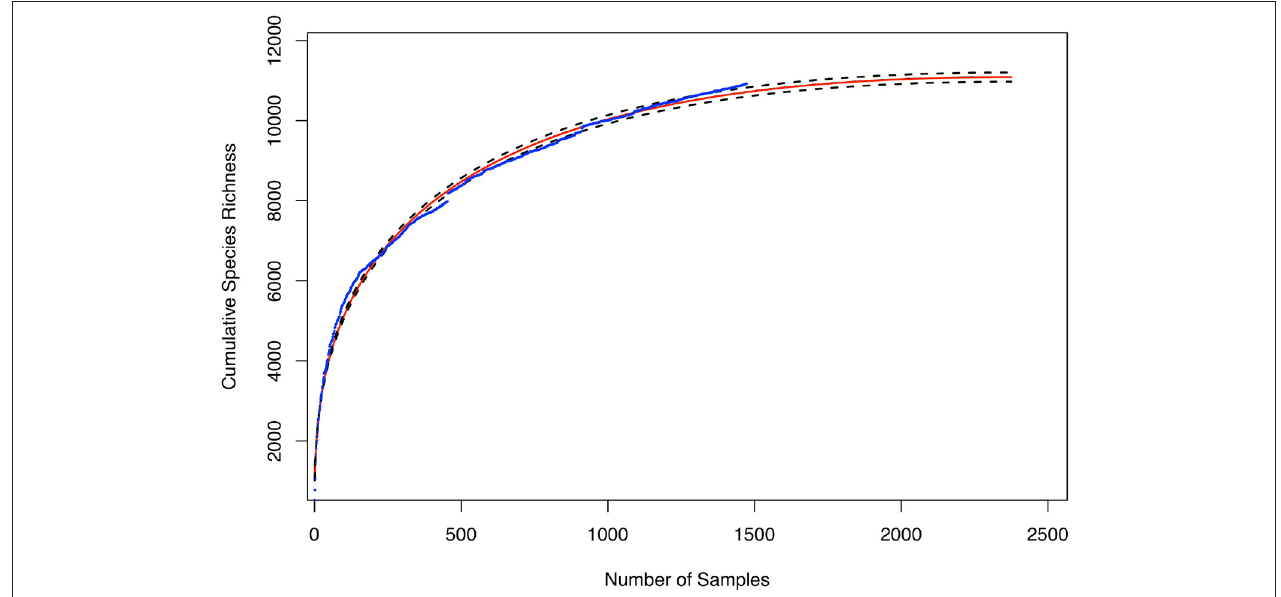
FIGURE 5 | Predicted species richness (solid curve in red color) of American gut microbiome (AGM) that includes lower and upper bounds (dashed lines) and observed species richness (solid tiny circles in blue